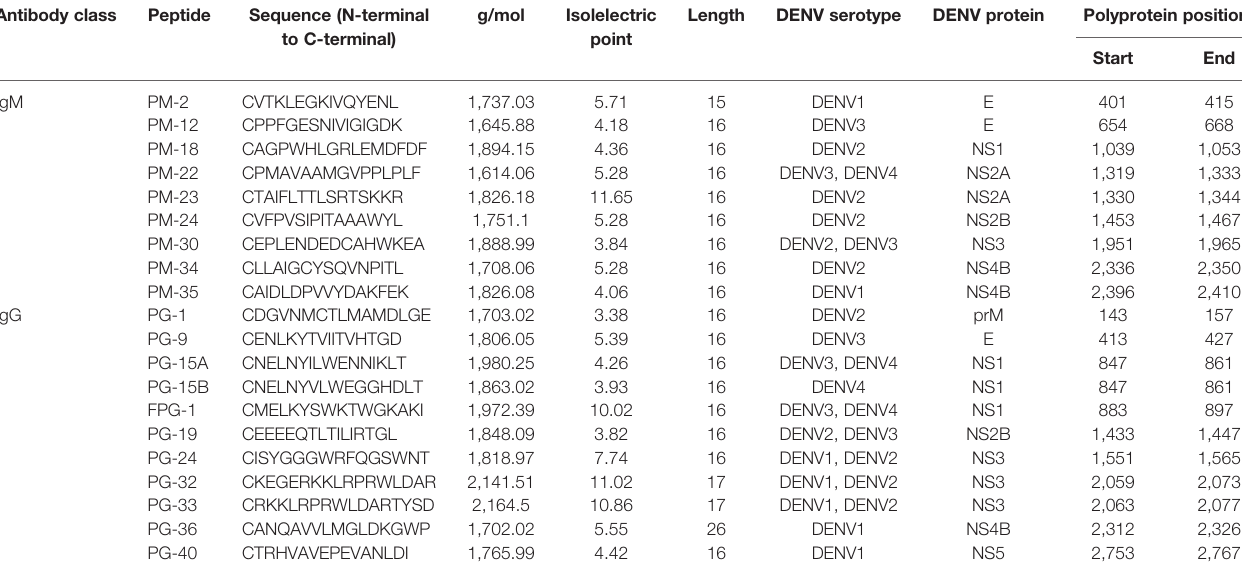
TABLE 2 | Overview of the peptides used in the